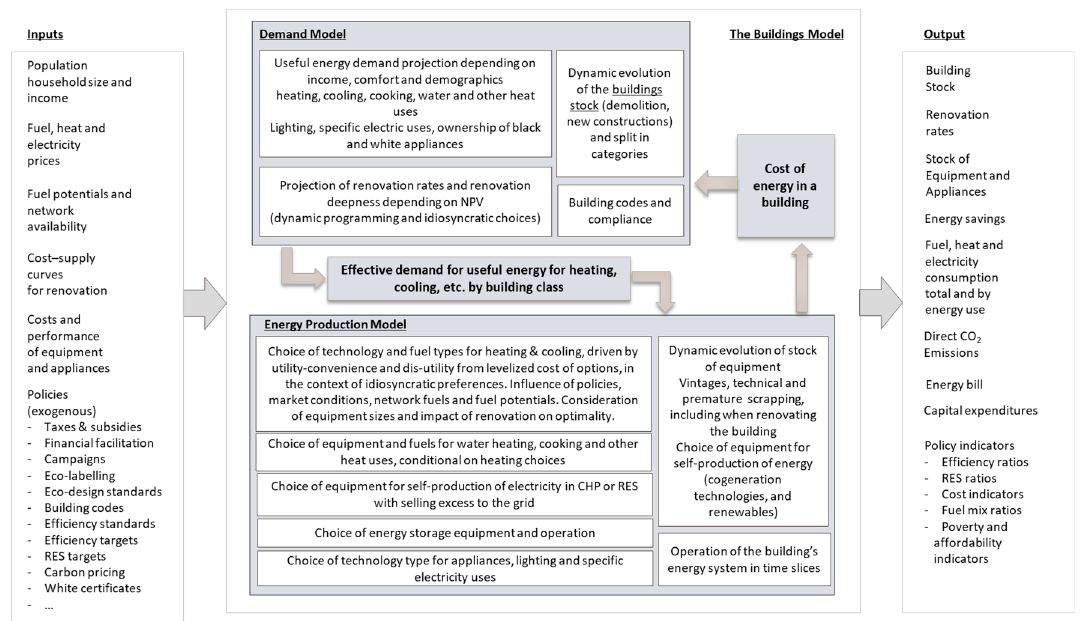
Figure 1. Flowchart of the PRIMES-BuiMo model [41].